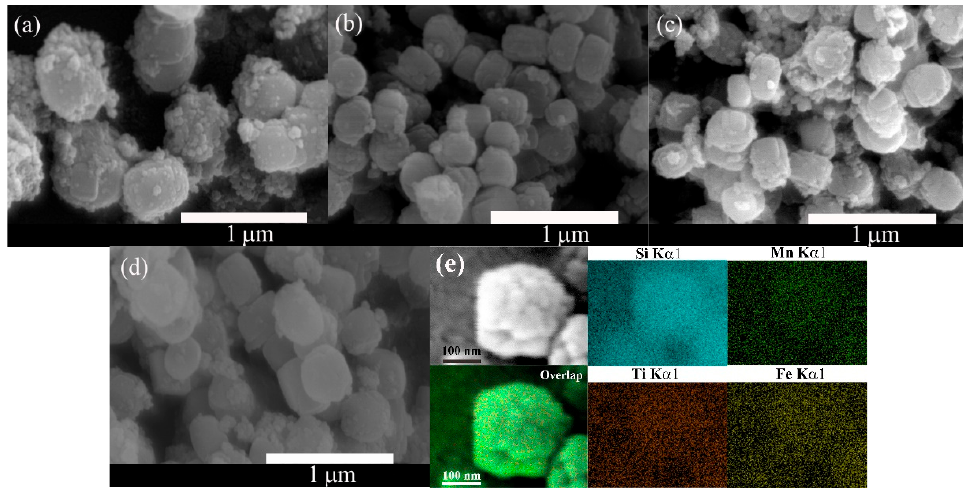
Figure 4. SEM images of Mn–Fe/TS-1(R-0) ( a ), Mn–Fe/TS-1(R-0.5) ( b ), Mn–Fe/TS-1(R-1) ( c ), Mn– Fe/TS-1(R-2) ( d ), and EDS mapping results of Mn–Fe/TS-1(R-2) ( e